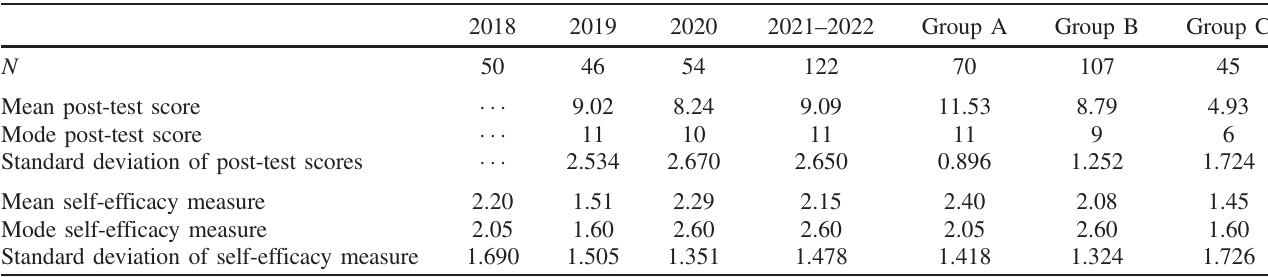
TABLE VI. Averages of post-test results (maximum points 13) and self-efficacy measures (ranging between − 2 . 71 and 5.27) by year and LCA